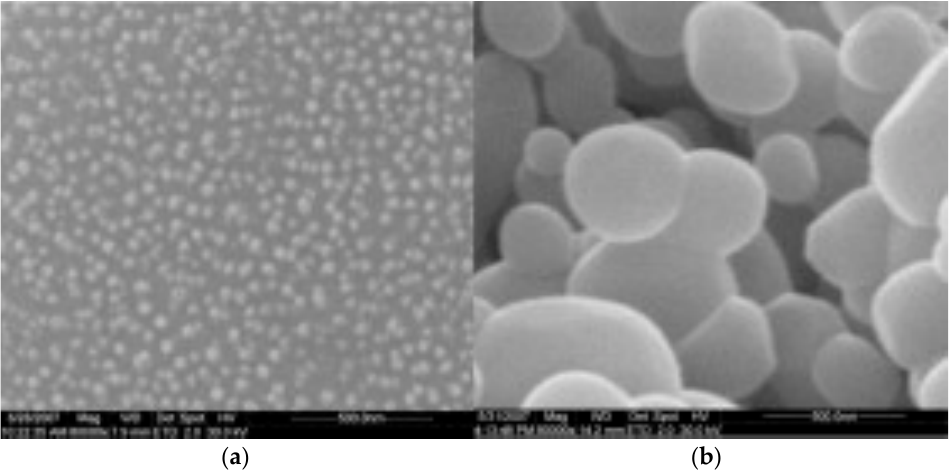
Figure 5. SEM images of Fe 3 BO 6 powders calcinated at ( a ) 800 ◦ C for 5 h and ( b ) 900 ◦ C for 3 h Reprint with permission [58] © 2008 Elsevier Inc. All rights